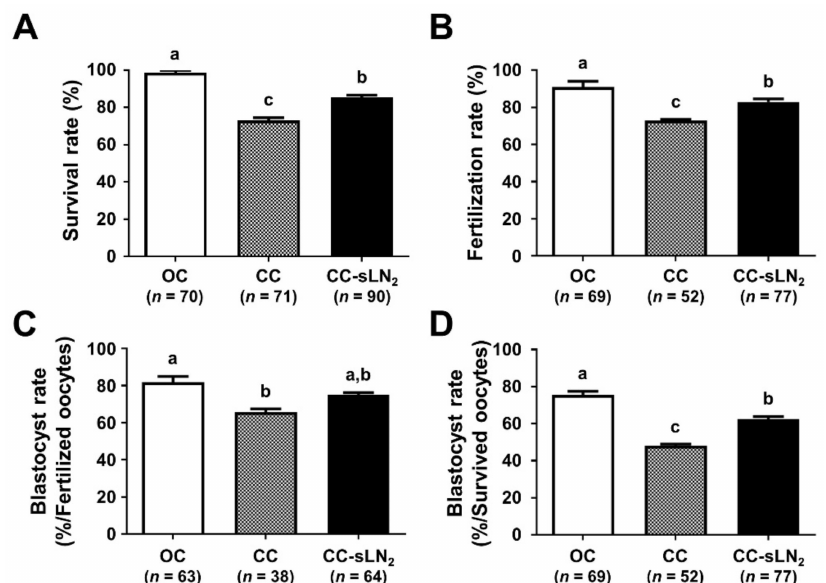
Figure 3. The effects of slush liquid nitrogen (LN 2 ) used to increase the cooling rate on the survival and development rates of vitrified/warmed (VW) oocytes. Comparison of the survival ( A ), fertil- ization ( B ), and blastocyst formation rates ( C , D ) of VW oocytes exposed to slush LN 2 . Blastocyst formation rates (the number of blastocysts/the number of fertilized oocytes ( C ) and/the number of survived oocytes ( D )). Different superscript letters (a–c) indicate p < 0.05. The number of experi- ments = 5 (13–19 oocytes per group in each experiment). OC, open carrier system; CC, closed carrier system with LN 2 ; CC-sLN 2 , closed carrier system with slush LN 2 .